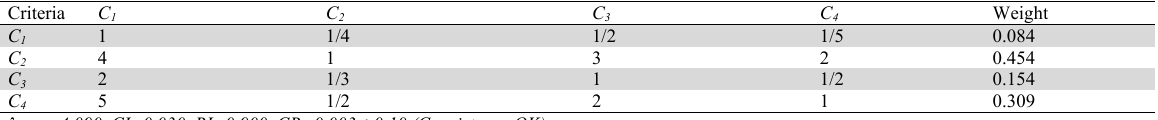
The values of pair-wise comparison matrices and weights of criteria